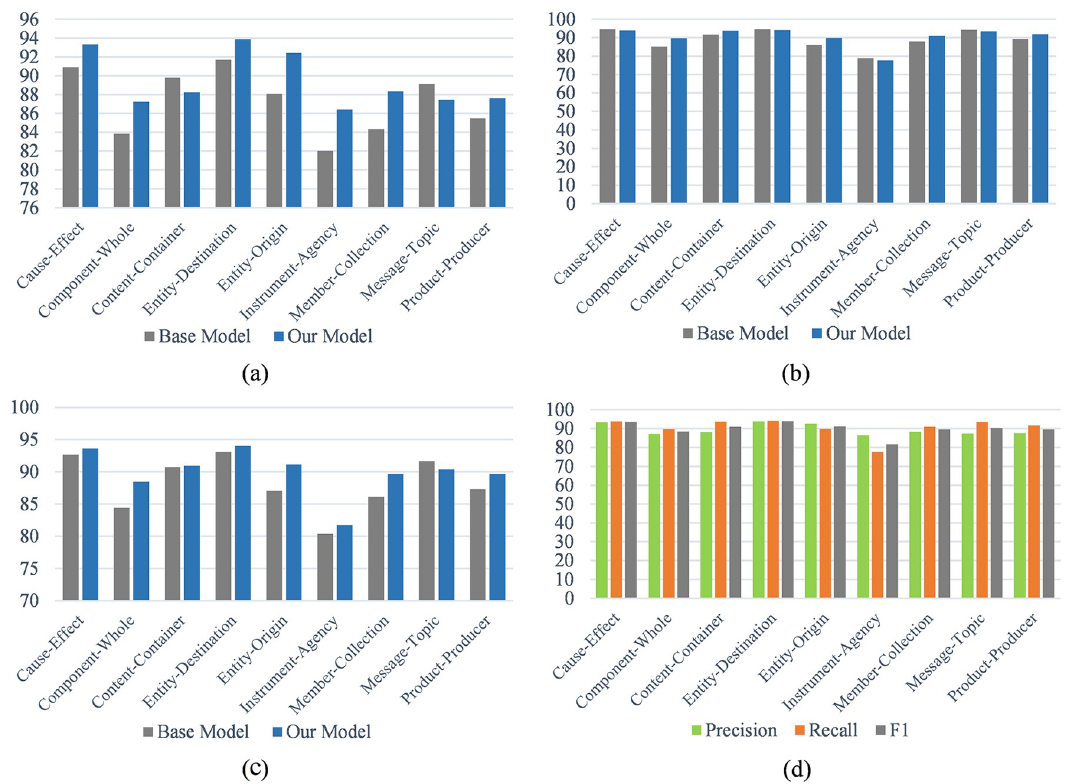
Fig 6. The influence of this module on the precision, recall and F1 of every